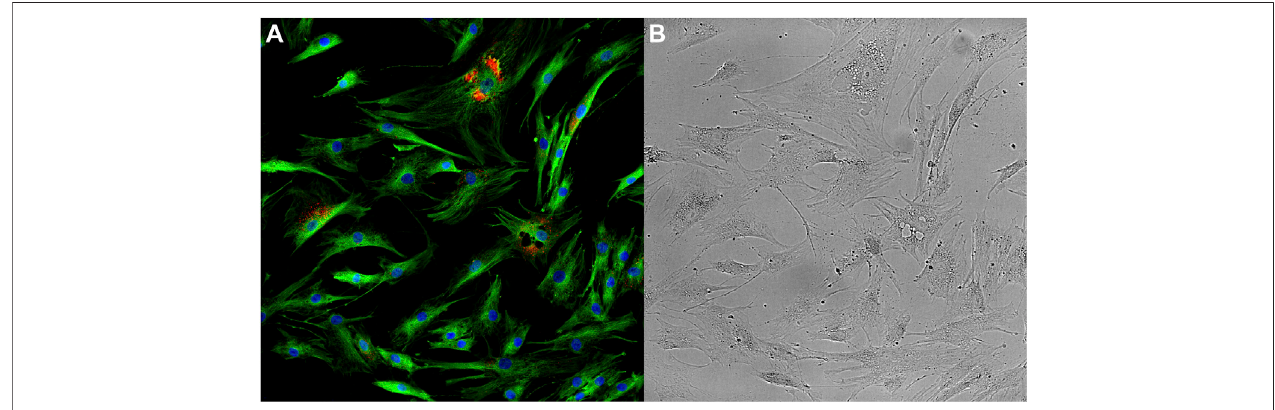
FIGURE1 | Optical microscopy images taken ofageing mesenchymal stemcells. Fluorescence image (A) provides information on the abundance and distribution of DNA (blue), α -Tubulin (green) and Senescence-associated beta-galactosidase (red). Bright fi eld image (B) provides information on the cellular and sub-cellular morphology. Images have been enhanced for